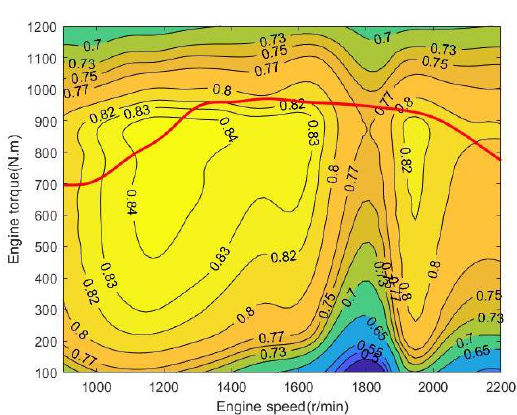
Figure 15. Efficiency characteristic field of HM2 at different speeds: ( a ) 8 km/h, ( b ) 9 km/h and ( c ) 11 km/h.